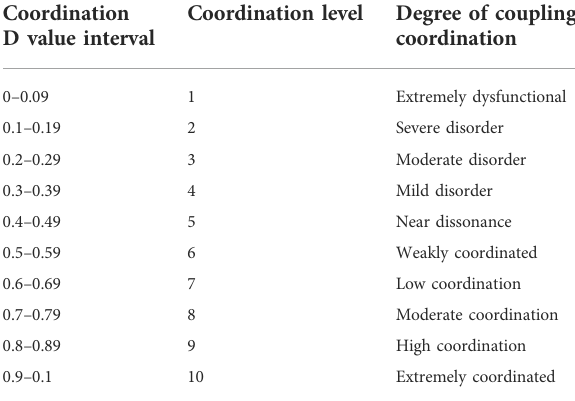
TABLE 2 Classi fi cation criteria of coupling coordination